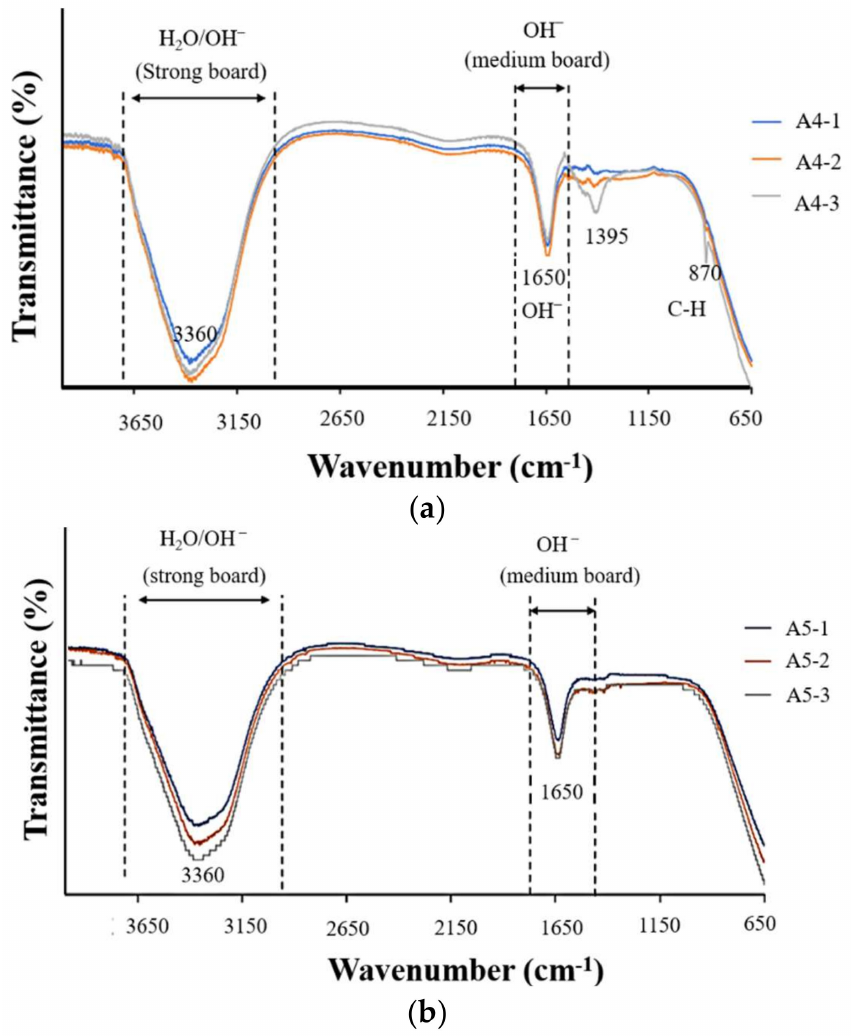
Figure 8. ( a , b ) FTIR was used to analyze the functional groups contained in the surface of calcium hydroxide-soaked materials, based on A4 (4-1, 4-2, 4-3) and A5 (5-1, 5-2, 5-3).